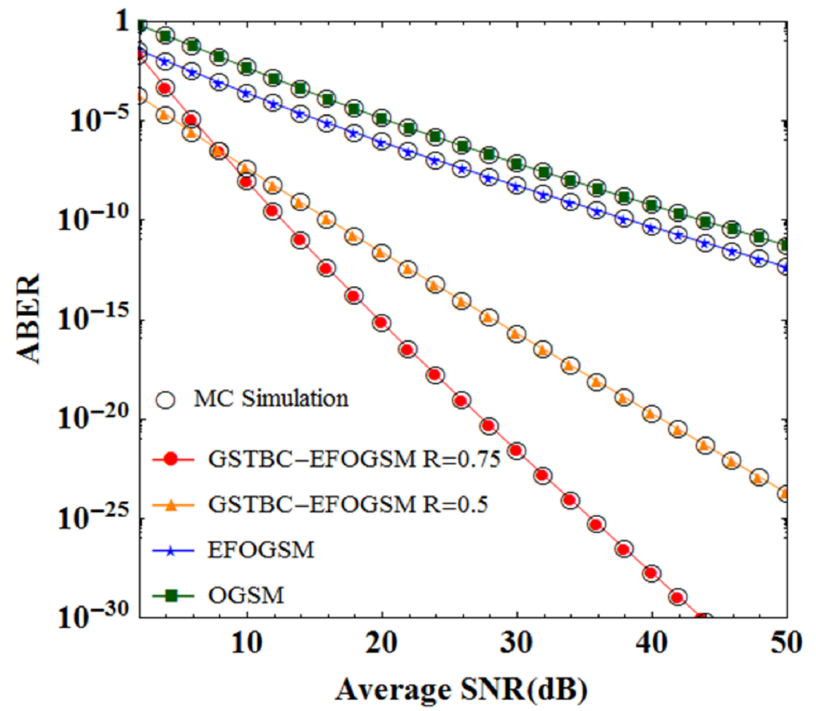
Figure 4. ABER comparison of GSTBC-EFOGSM, EFOGSM and OGSM schemes at the same data transmission